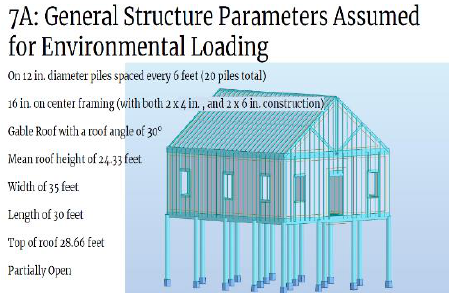
Figure 5. Contour map of model-predicted current speeds for 100 yr storm with 3.2 ft SLR.